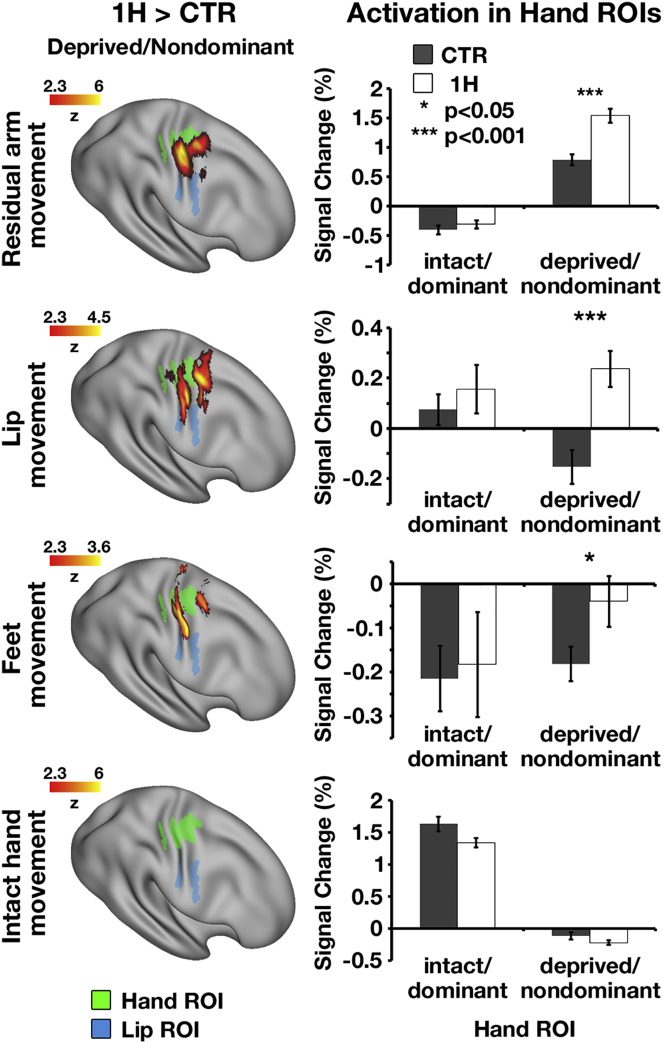
Movements of Body Parts Used for Compensatory Behavior Activate One-Handers’ Missing-Hand TerritoryLeft: group-contrast maps during residual/nondominant arm (one-handers/controls), lips, feet, and intact/dominant hand movements, projected onto an inflated surface of a template brain. In each of the arm, lips, and feet (but not intact hand) conditions, one-handers showed increased activation compared to controls, centered in the missing-hand territory. Green and blue shadings indicate the hand and lip ROIs, respectively.Right: ROI analysis, comparing group activation in the bilateral hand territories. Activation levels in one-handers’ missing-hand territory (white bars) were greater than activations in controls’ nondominant-hand territory (gray bars) in all but the intact-hand condition. 1H, one-handers; CTR, controls; intact/dominant, hemisphere contralateral to the intact/dominant hand; deprived/nondominant, hemisphere contralateral to missing/nondominant hand. Error bars depict SEMs.See also Figures S1 and S3 and Tables S1 and S2.